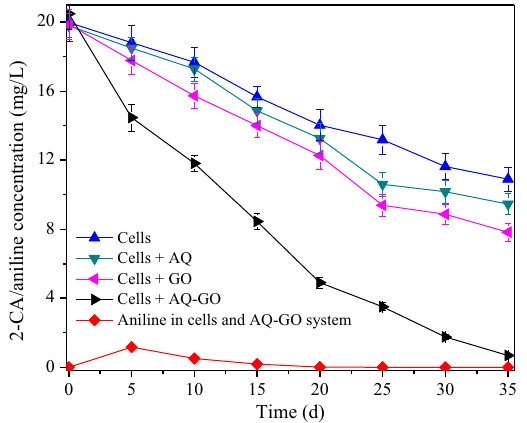
Figure 3. Time course of 2-CA biodegradation in different reaction systems. Error bars show one standard